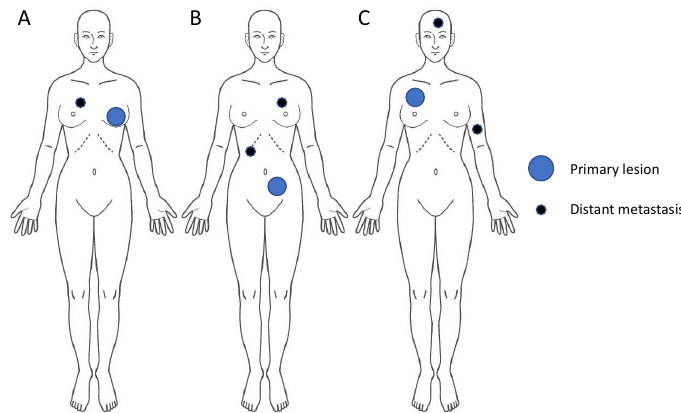
Figure 1. Schema of oligometastasis. Cases A , B, and C represent breast cancer with solitary pulmonary metastasis, colon cancer with liver and lung metastases, and non-small-cell lung cancer with brain and bone metastases, respectively. In oligometastatic disease, the number of metastatic lesions is limited, and both the primary and metastatic lesions should be treated with local treatment.